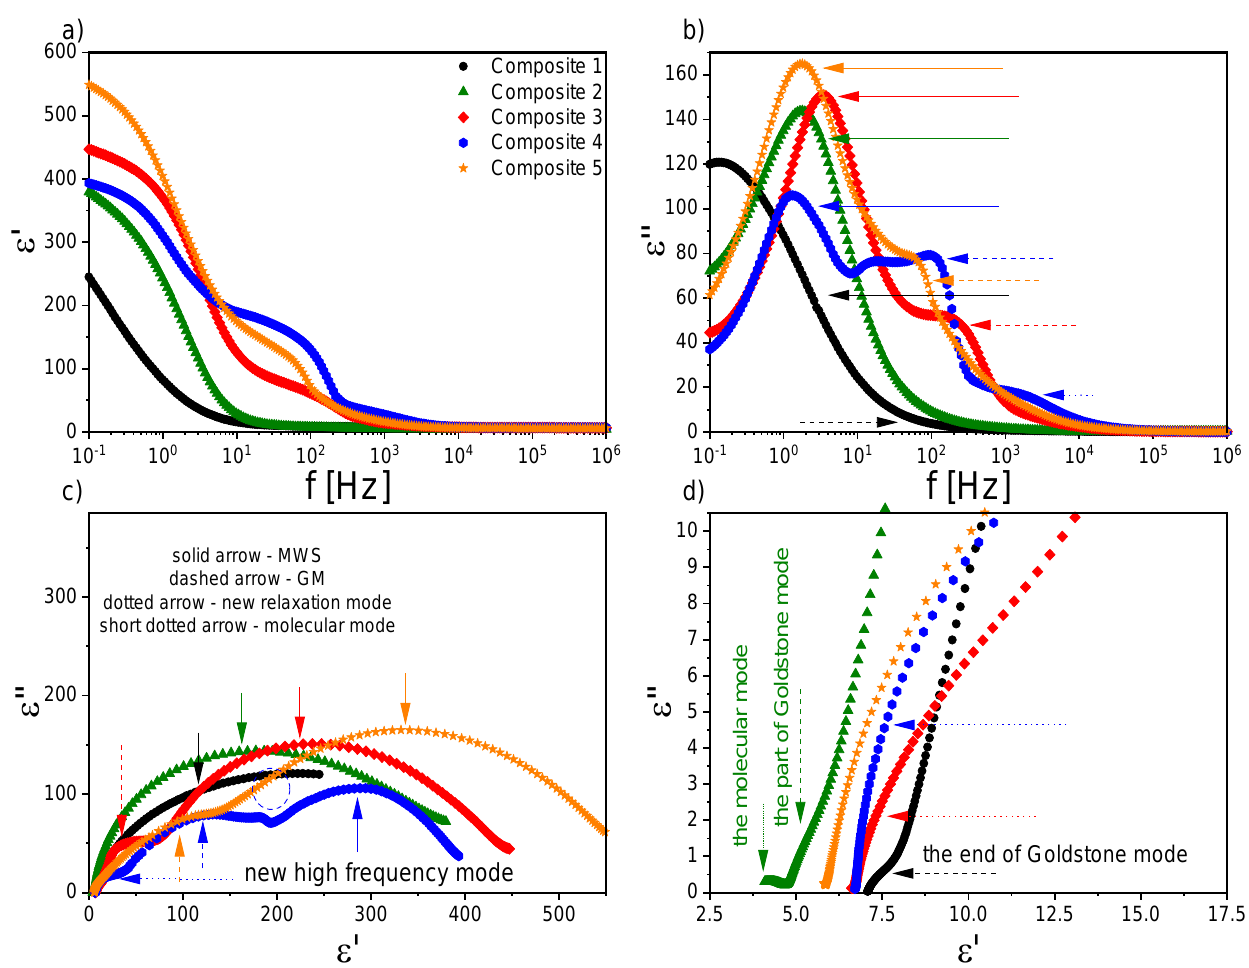
Figure 9. Dielectric spectra of Composites 1 – 5 in the ferroelectric SmC* phase (60 °C): dispersion ( a ); absorption ( b ); Cole–Cole plot ( c ); enlarged high-frequency part of Cole–Cole plot ( d ). Continuous colored arrows indicate the MWS process, dashed—the GM, dotted—a new relaxation process, and short-dotted—a molecular process. The legend in graph ( a ) is the same for all graphs. The dashed blue circle in graph ( c ) indicates an additional relaxation process present between the MWS and the Goldstone processes for Composite 4.